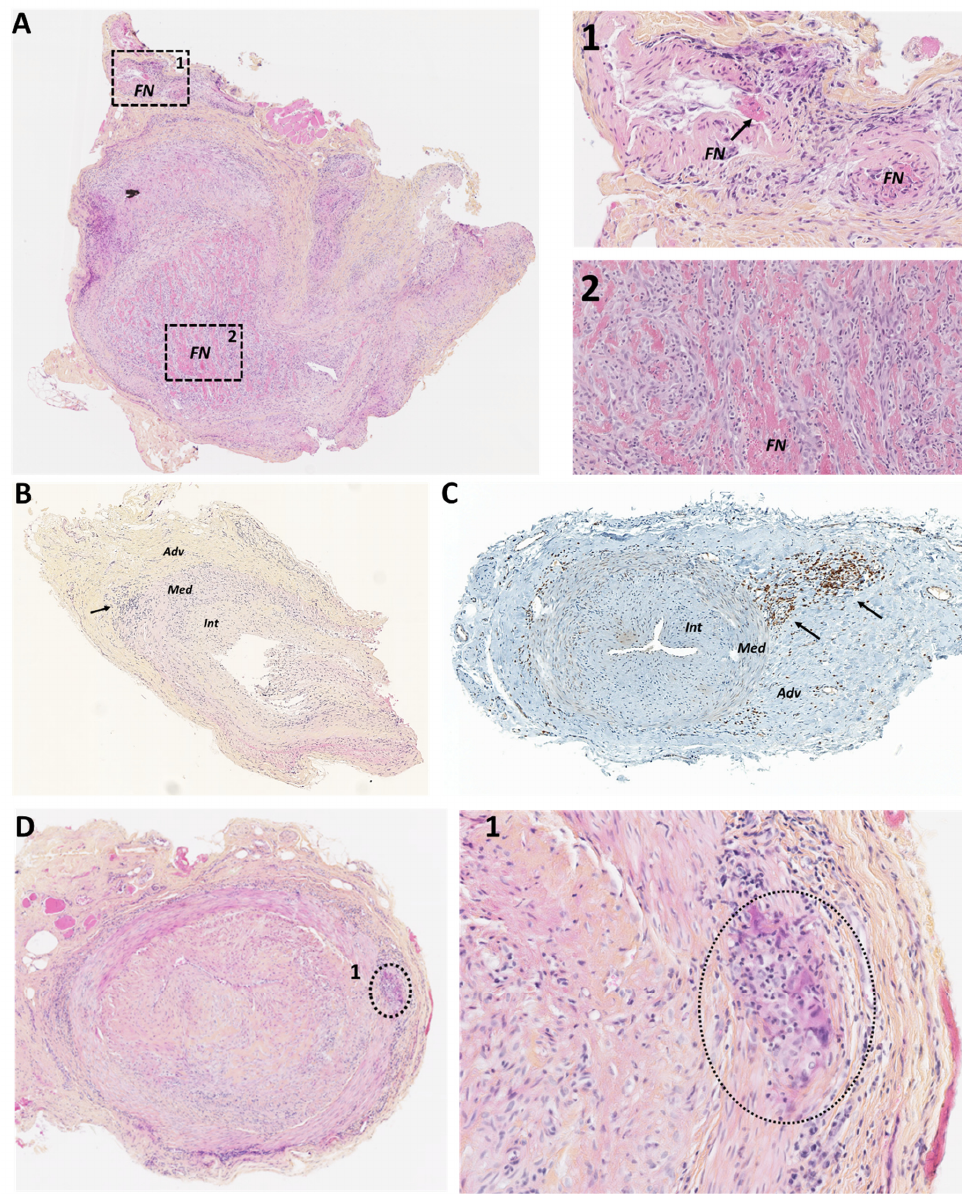
Figure 3. Histological sections of temporal artery biopsies (TAB). ( A ): TAB showing fibrinoid necrosis within the temporal artery (TA) (A1) and in the peri-adventitial vasa-vasorum (A2); ( B ): TAB showing vasculitis limited to the adventitia (arrow); ( C ): immunohistochemistry showing T-cell (CD3) labeling in a TAB with vasculitis limited to the adventitia (arrow). ( D ): TAB from a patient with sarcoidosis showing an epithelioid and gigantocellular granuloma at the media-adventitia junction. Adv: adventitia; TA: temporal artery; Int: intima; Med: media; NF: fibrinoid necrosis.